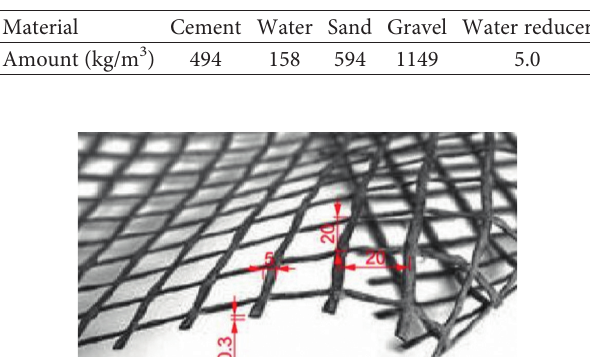
Table 1: Mixing proportions of concrete.